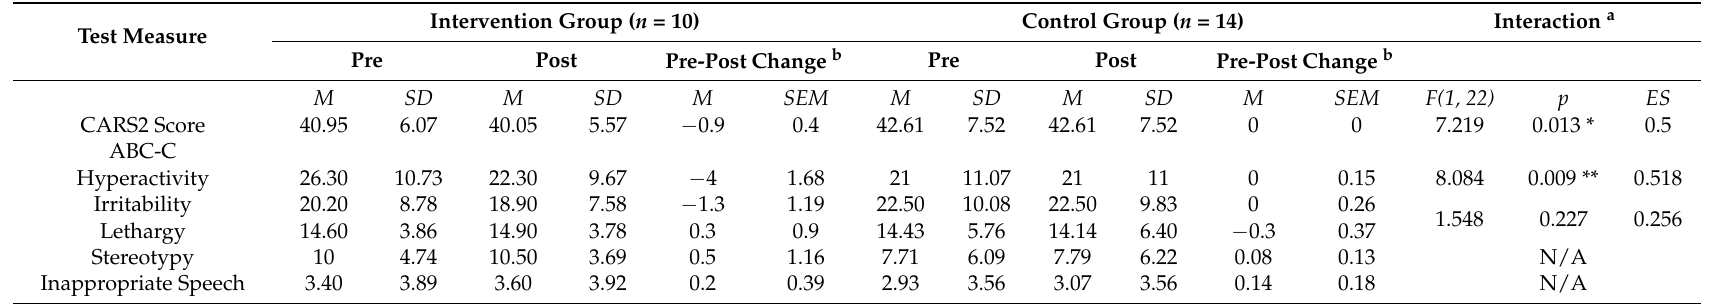
Table 2. Analysis of efficacy of horse riding intervention compared to an education as usual